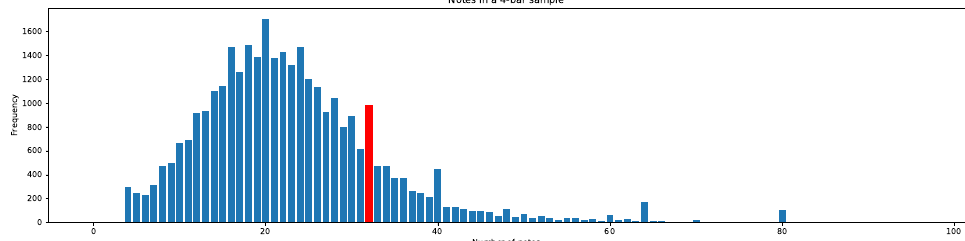
Figure 6. The frequency of number of notes in a four-bar sample. The horizontal axis represents the number of notes in a four-bar sample, and the vertical axis illustrates the frequency of samples with a specific number of